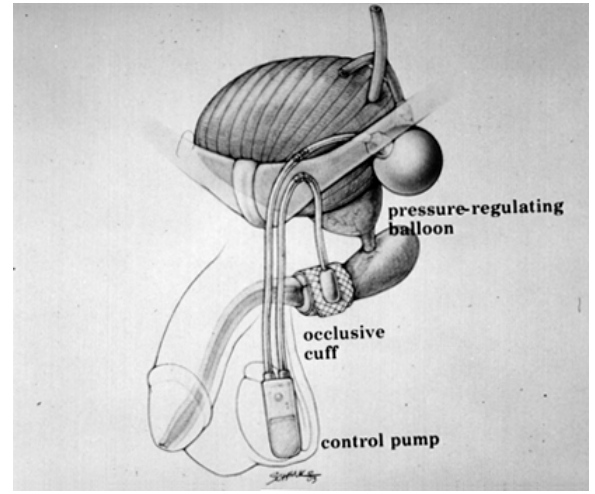
FIGURE 2 . The position of the bulbous urethral cuff, reservoir, and pump in the adult